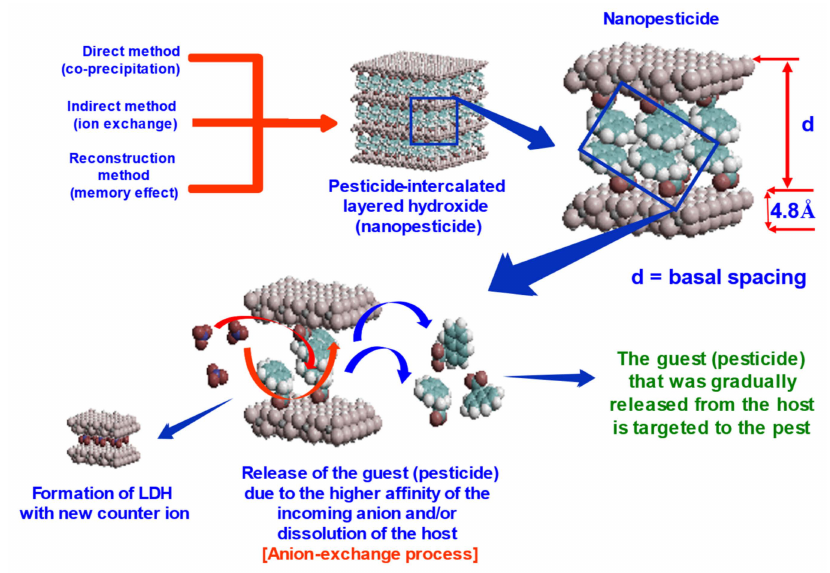
Figure 4. Layered double hydroxide inorganic 2D structure, the formation of the nanopesticides by adopting host–guest supramolecular chemistry, and the release of the guest from the host via the ion exchange process, together with the dissolution of the host and the possible formation of the “new” LDH with the new incoming anions that are available in the surrounding